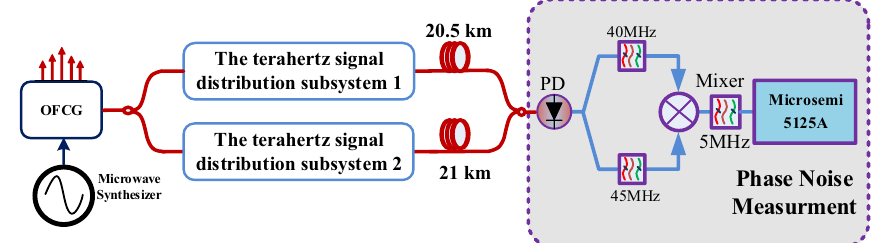
Fig. 3 Experimental setup for the stable terahertz-wave signal distribution system and the phase measurement. OFCG, optical frequency comb generator; PD